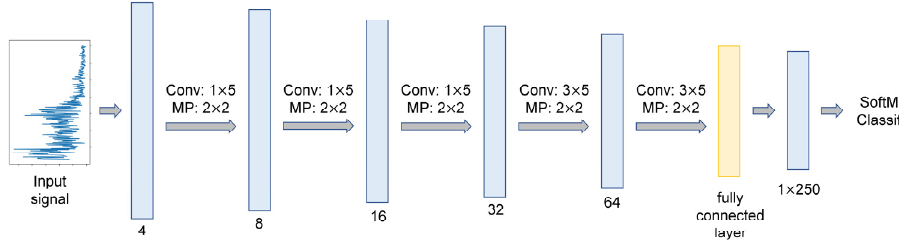
Figure 3. Structure of the proposed CNN Model.